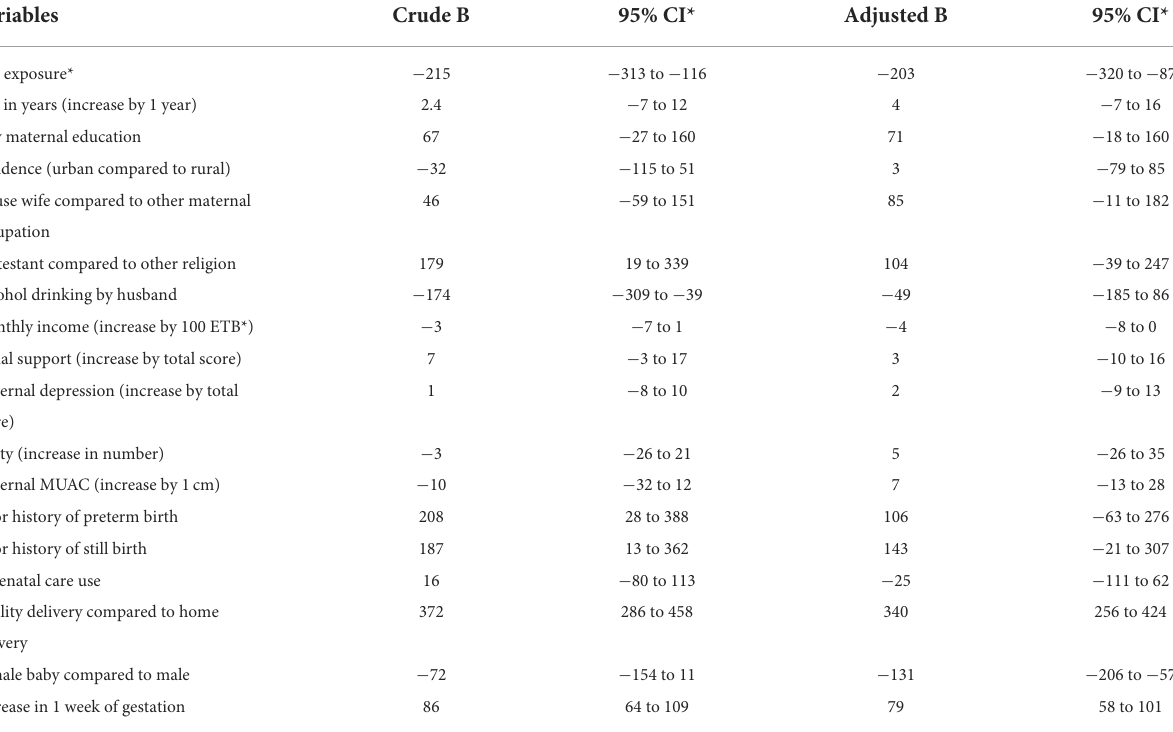
TABLE 3 Multivariable linear regression of factors associated with birth weight in Wondo Genet district, southern Ethiopia, 2017 ( n = 505).